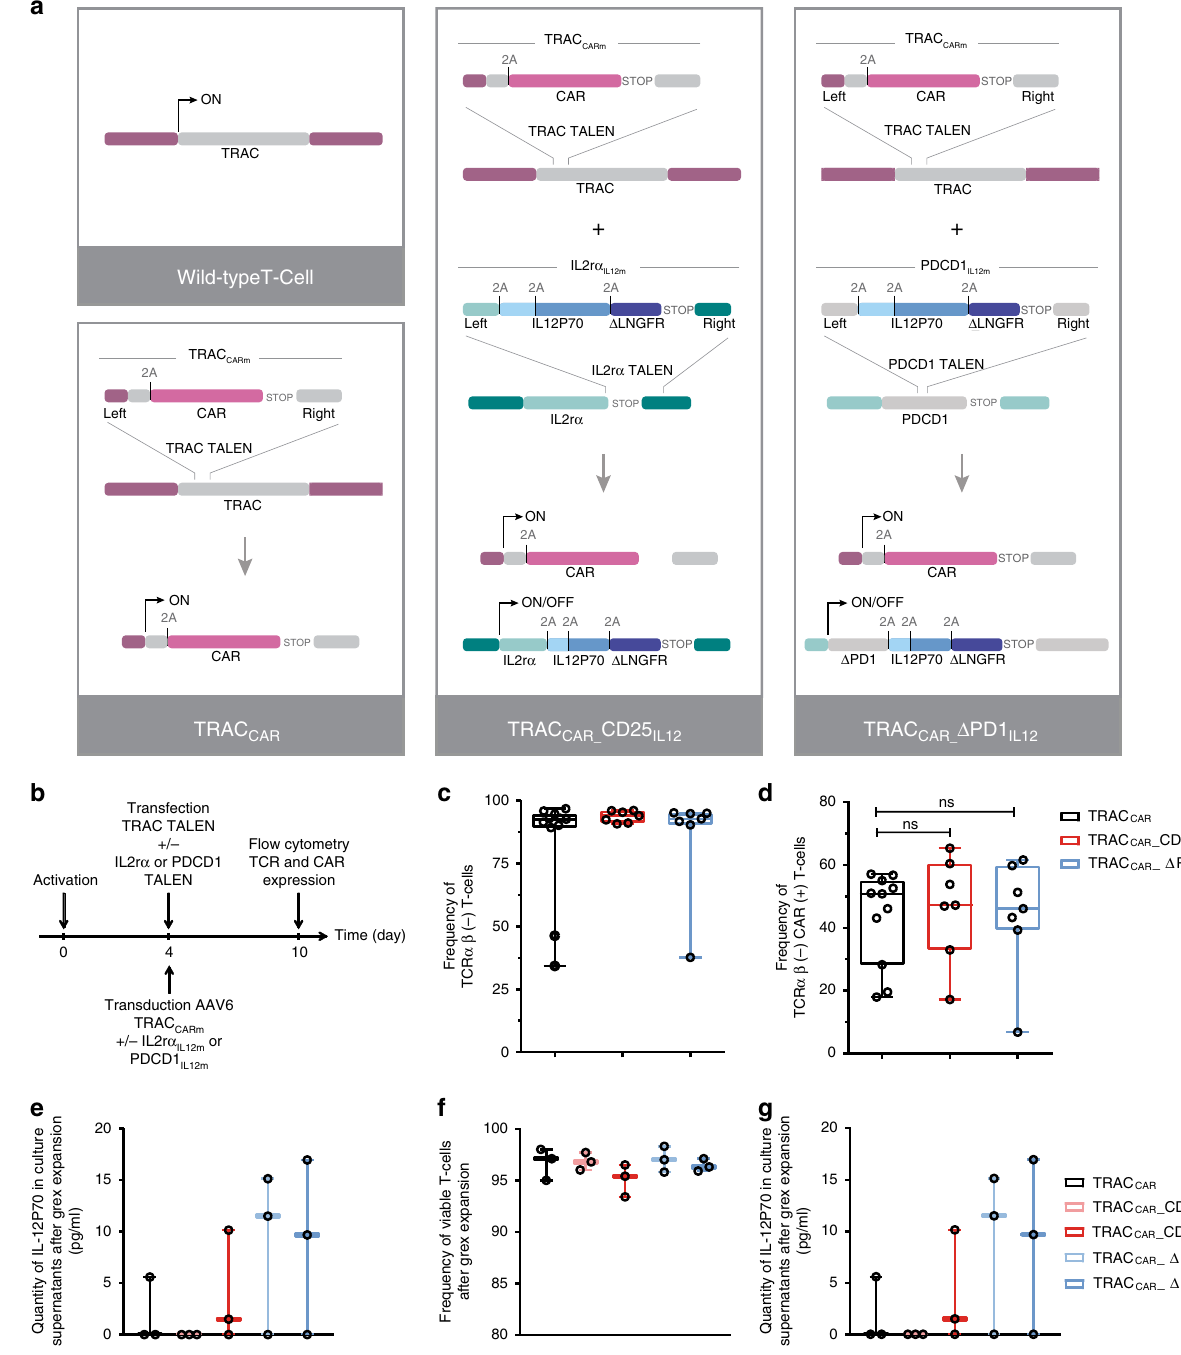
Hybridization (FISH). Karyotyping and G-banding pattern on chromosome 10 or 2 (PDCD1 and IL2r α loci) and of results were consistent with human diploid samples devoid of IL2r α IL12m or PDCD1 IL12m on chromosome 14 (TRAC Locus). gross structural abnormalities or clonal chromosomal aberrations The molecular signature of these marginal events suggests co- (Fig. 2b, d). Consistently, FISH analysis did not show signi fi cant integration of matrices concatemeres at TRAC, IL2r α , and difference ( p = 0.766, Chi square) between the frequency of PDCD1 loci in a few cells, although we cannot exclude homology- TRAC/PDCD1 or TRAC/IL2R α gene fusion obtained in engi- independent trapping of matrices at the three loci. neered T cells and in MRC5, a human fi broblast cell line considered a reference diploid cell line and commonly used as a negative control for gene fusion detection (Fig. 2b, d). Although two targeted loci 41,42 , we characterized cytogenic properties of the low sensitivity of this test does not rule out translocation by karyotyping and Fluorescence-In-Situ- (sensitivity of FISH analysis ~ 1 – 4%), it indicated that they